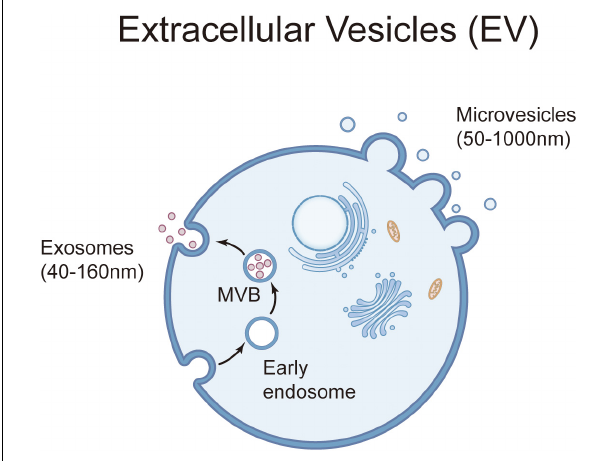
FIGURE 1 | Generation and release of extracellular vesicles. Extracellular vesicles are a heterogeneous group of cell-derived membranous structures comprising microvesicles (50 nm–1 µ m diameter) and exosomes (40–160 nm diameter). Microvesicles are shed from the plasma membrane, while exosomes originate from the endosomal system. Exosomes are secreted from cell to extracellular space by exocytosis after fusion of multivesicular body (MVB) (formed by endocytic vesicles) with plasma membrane.